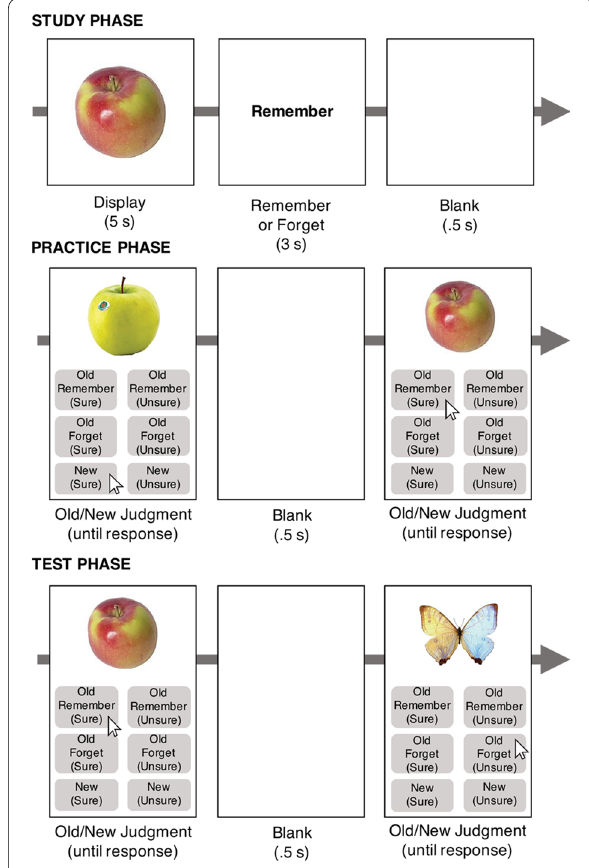
Fig. 3 Experiment 2 Methods. The stimuli, task, and three phases were identical to Experiment 1 with the following exception. Participants had six response choices instead of four, pictured above. Not pictured: in a post-experiment survey participants were asked whether they believed the Forget items would be